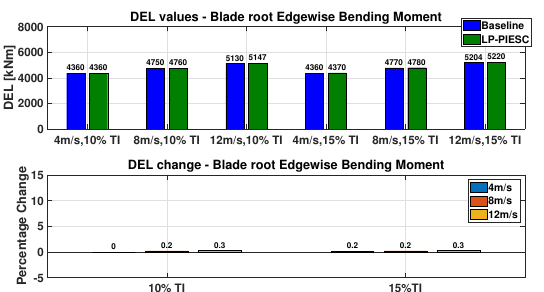
Figure 19. Blade-root edge-wise bending moment comparison: Baseline vs. LP-PIESC. Aggregate DEL values with baseline controller and LP-PIESC ( top ), percentage change in DEL ( bottom ) for time series from 150 s to 3000 s.